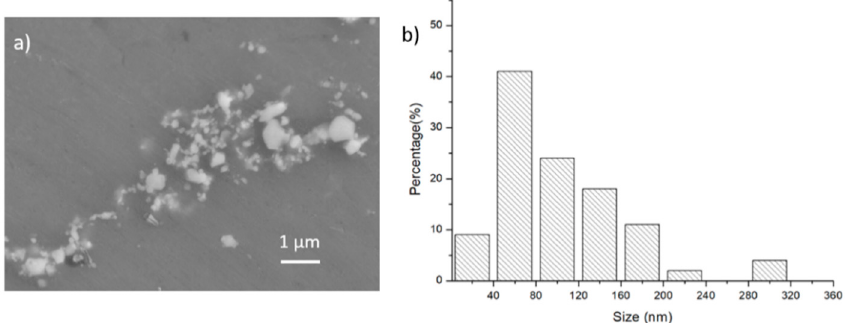
Figure 2. SEM images of as-cast samples: ( a ) A-0Cu-NP, ( c ) A-0Cu, ( e ) B-0.5-NP, ( g ) B-0.5Cu, ( i ) C-1Cu-NP, ( k ) C-1Cu. Corresponding SEM images of samples after solution treatment at 473 °C for 1.5 h: ( b ) A-0Cu-NP, ( d ) A-0Cu, ( f ) B-0.5-NP, ( h ) B-0.5Cu, ( j ) C-1Cu-NP, ( l ) C-1Cu.